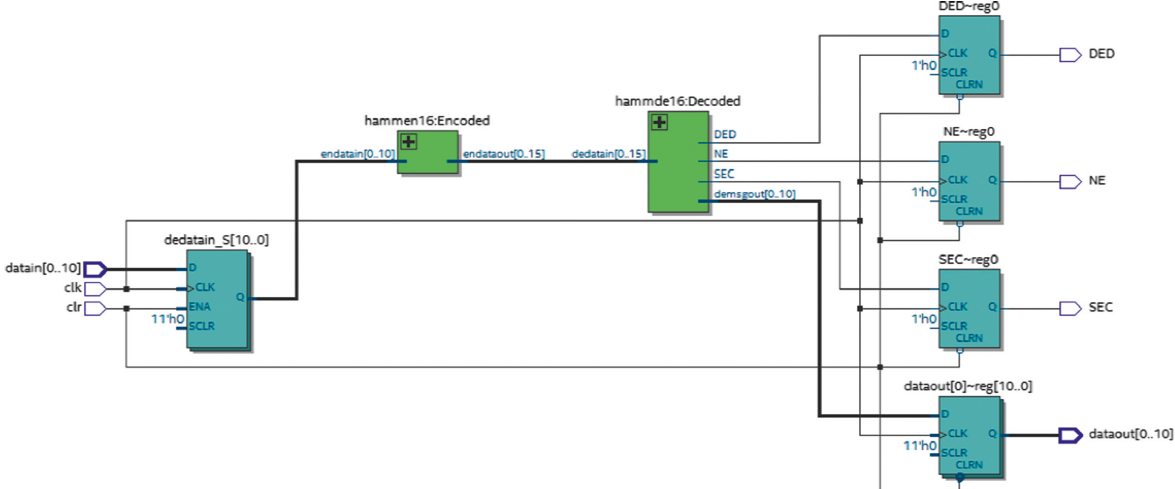
Figure 15: Full RTL overview of VHDL code for Hamming [16, 11, 4]